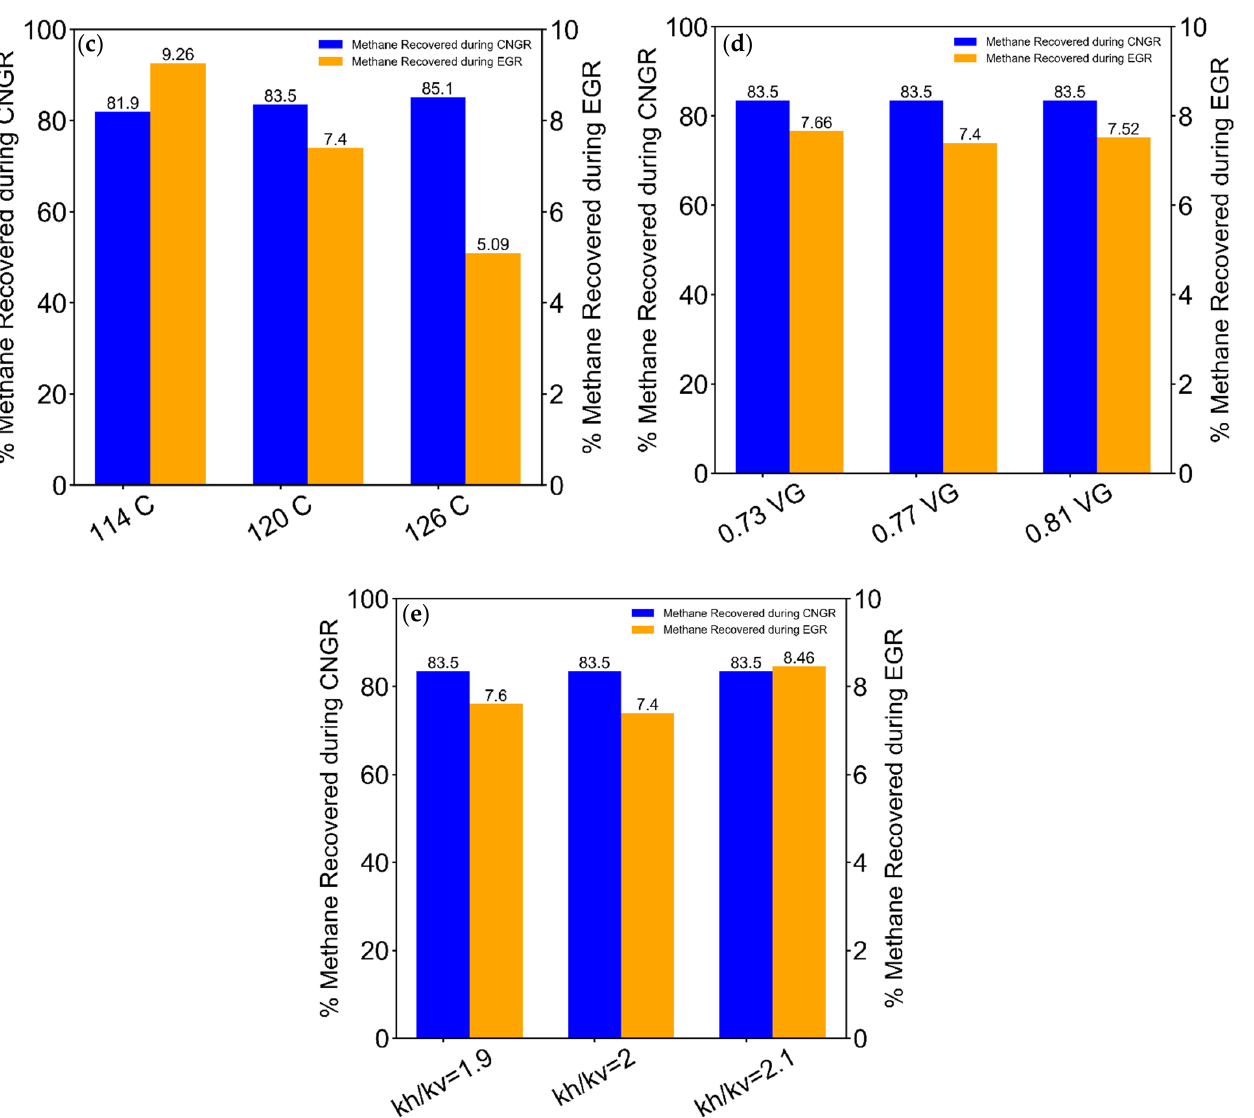
Figure A1. Percentage of original gas in place (OGIP) recovered during the CNGR and EGR stages for the four reservoir model example cases ( a ) and the four reservoir parameters (permeability ( b ), temperature ( c ), relative permeability ( d ), and permeability anisotropy ( e )).